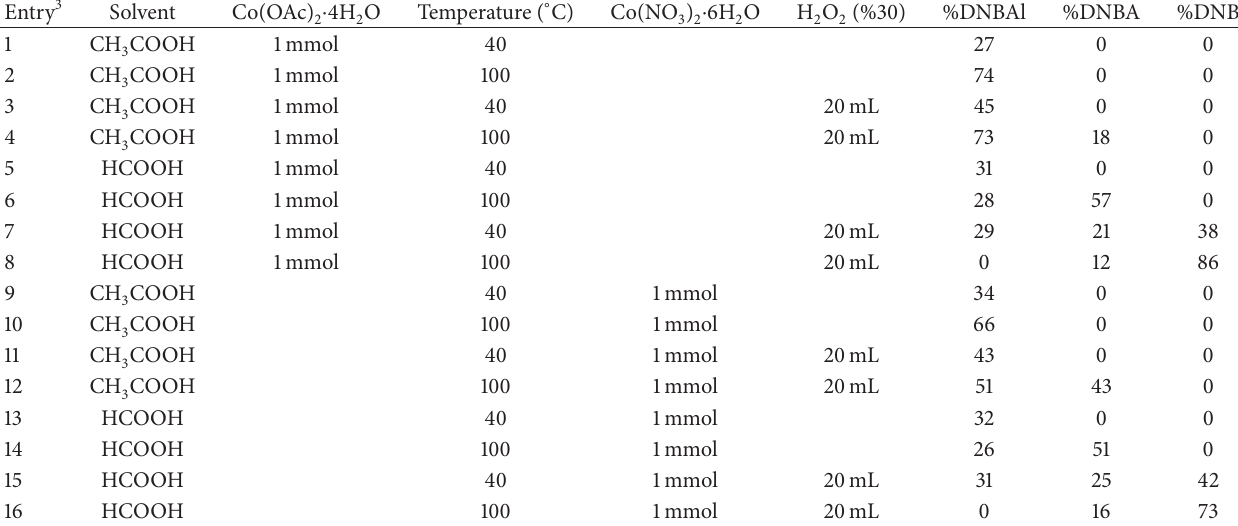
Table 2: The conditions and results of the oxidation of DNT.